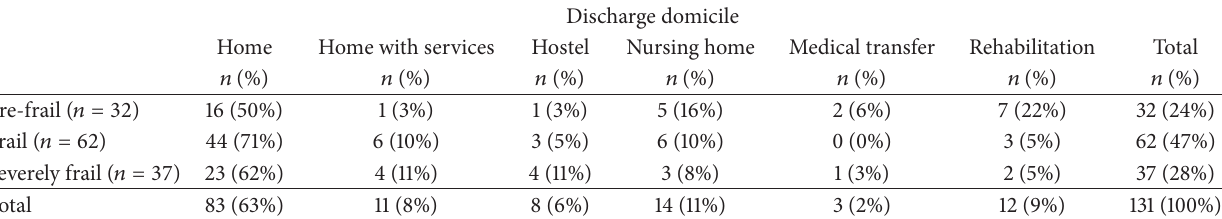
Table 3: Frailty status by discharge domicile cross-tabulation.